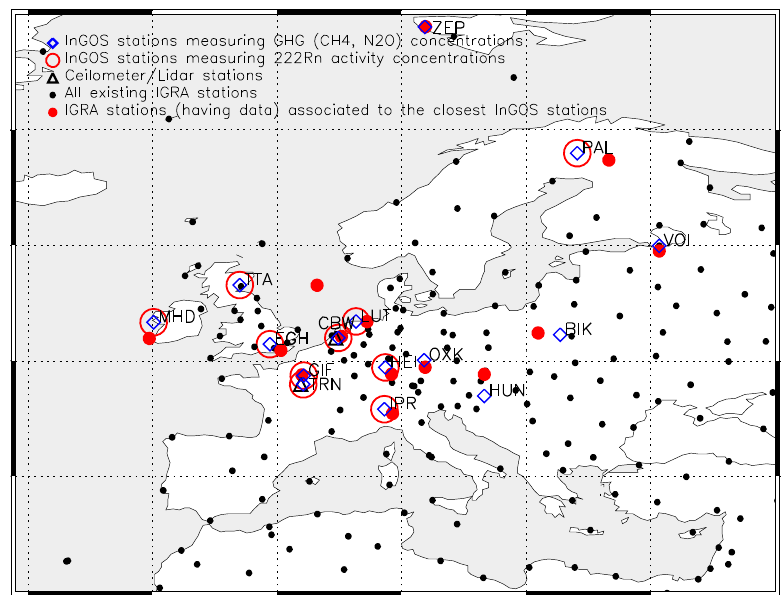
Figure 1. Observational network of InGOS greenhouse gas (CH 4 , N 2 O) and radon ( 222 Rn) concentration measurements and boundary layer height observations, blue diamonds: INGOS stations that measure CH 4 and/or N 2 O concentrations; red circles: InGOS stations that measure radon ( 222 Rn) activity concentrations; black dots: all existing IGRA stations; red dots: IGRA station closest to InGOS station; triangles: ceilometer/lidar measurement sites (i.e. Cabauw/Traînou). The acronyms for the stations measuring 222 Rn activity concentrations are compiled in Table